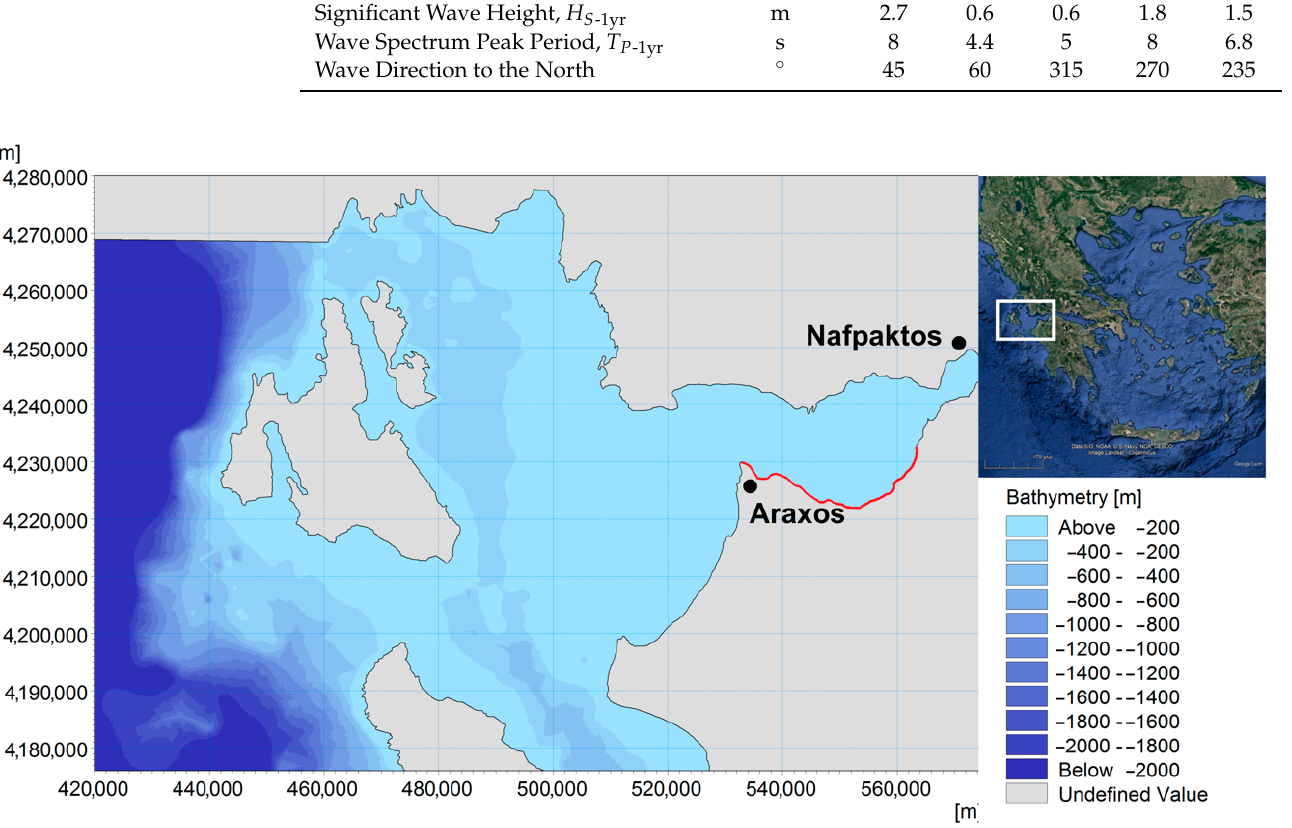
Figure 7. The bathymetry of the computational domain of the Gulf of Patras and part of the Ionian Sea used in the numerical simulations (stage 1) of wind-induced wave generation, growth, and propagation. The red line indicates the coastline of the study area, while the black points indicate the location of the meteorological stations at Nafpaktos and Araxos.